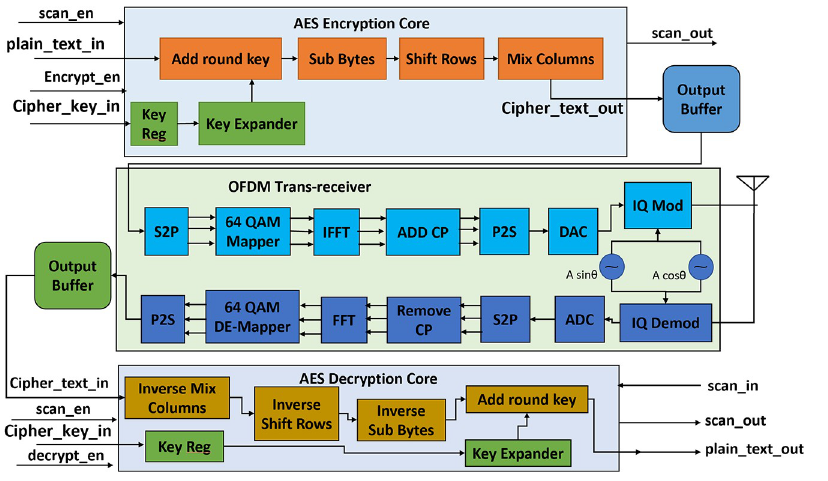
Fig 4. Detailed block diagram of trojan free IC.